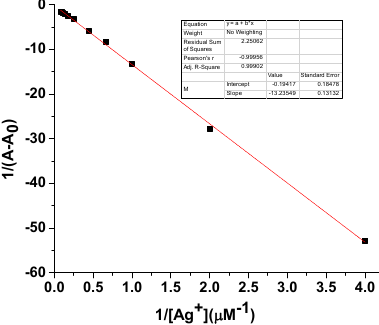
Figure 7. Benesi – Hildebrand plot of QCy with Ag + .